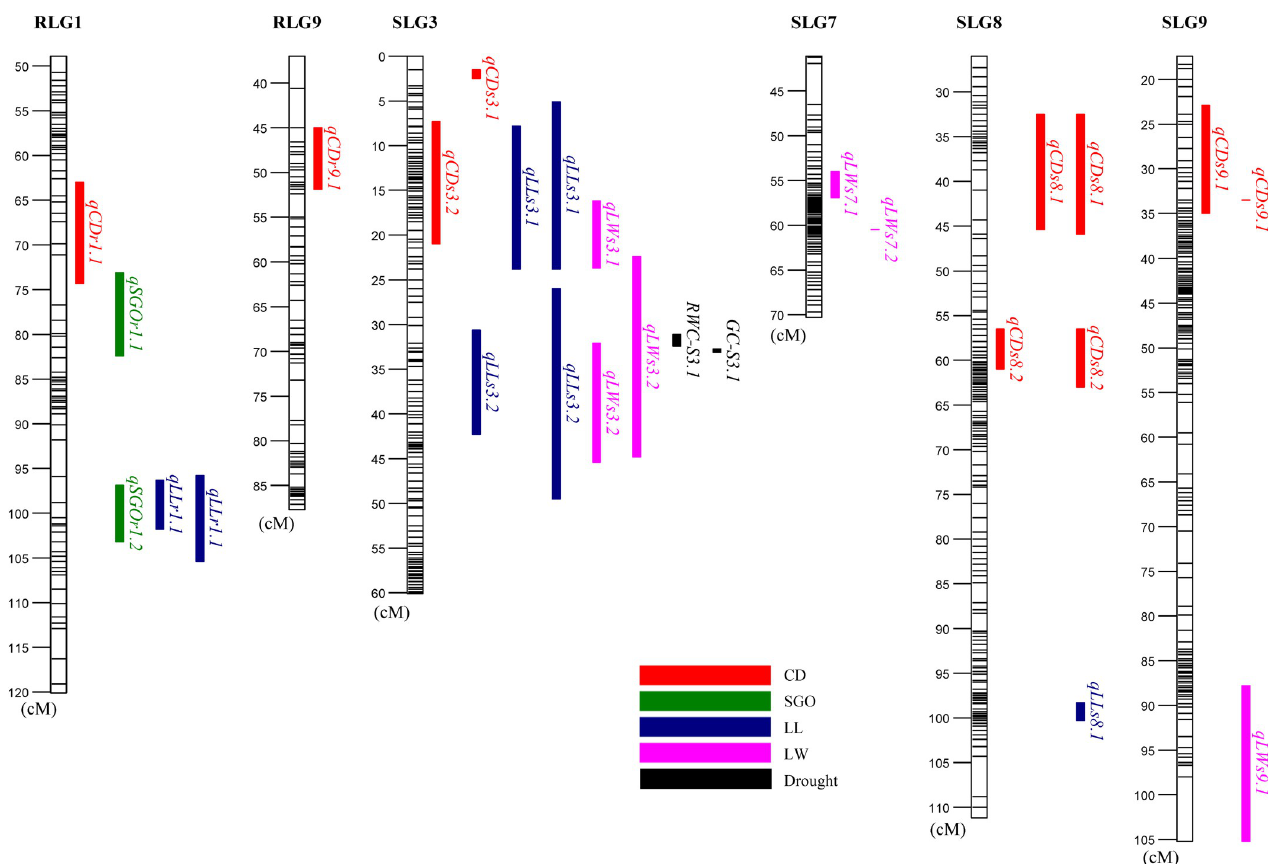
Fig 3. Distribution of quantitative trait loci (QTL) for morphological and canopy traits in a St. Augustinegrass Raleigh x Seville F 1 population evaluated in greenhouse (GH) and field (TFL and SRS) trials. Morphological traits include leaf width (LW), leaf length (LL), canopy density (CD) and shoot growth orientation (SGO). QTL for drought traits including percent green cover (GC) and relative water content in leaves (RWC) were previously reported in Yu et al. (2019) [10].